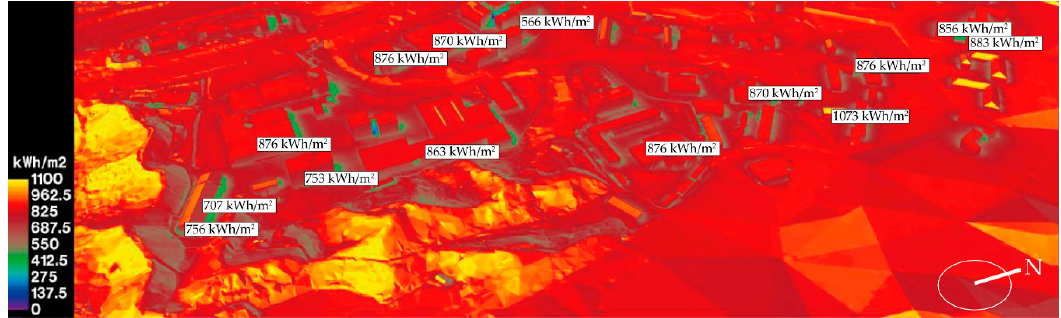
Figure 4. Annual irradiation map of Sluppen. The labels show irradiation values at selected points.